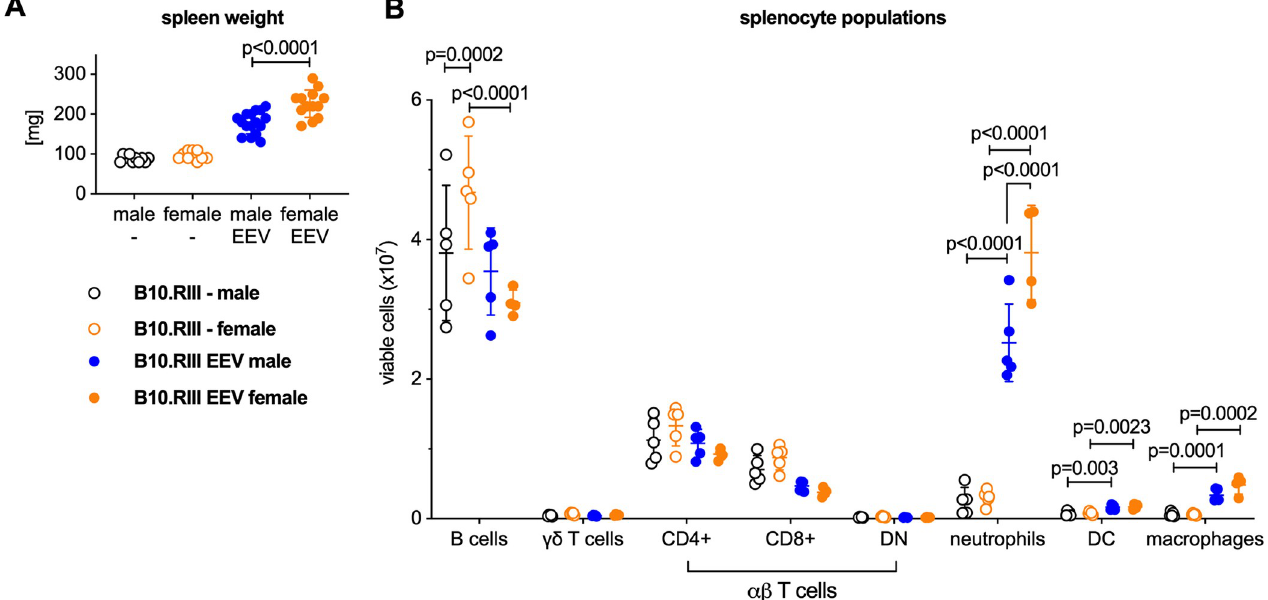
Fig 9. Female B10.RIII mice exhibit greater expansion of myeloid cells in the spleen after hydrodynamic injection of IL-23 EEV. (A) Spleen weight of the mice from the experiment in Fig 8. (B) For a subset of animals, single cell suspensions were prepared from the spleens and analyzed by flow cytometry, n = 4–5 mice/group. P values were determined by unpaired